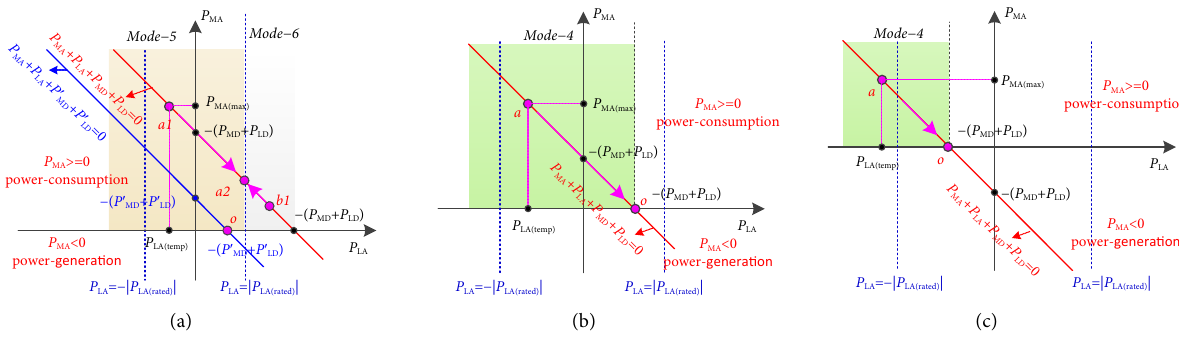
Fig. 3 LVRT mode classification of the PET under different power configurations in the power-consumption state of the MVac port. (a) Case 4 , | P LA(rated) ⩾